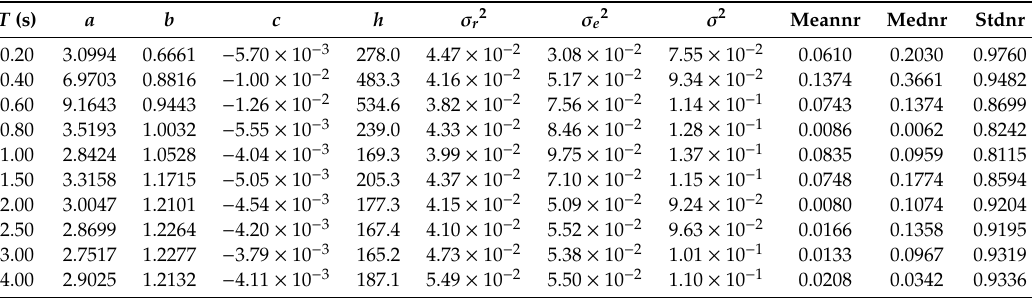
Table A4. Coe ffi cients of the GMPE for set 3, Equation (1), ground type